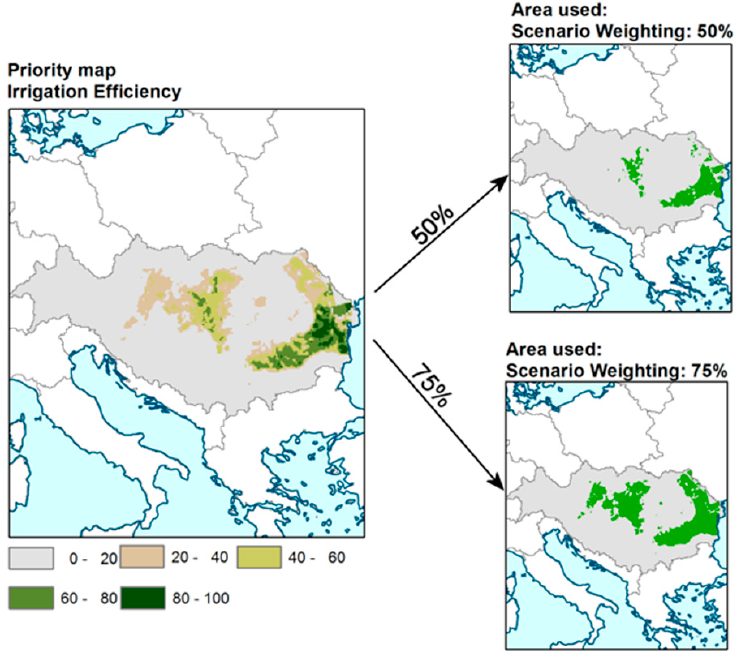
Figure 3. Scenario intensity example: Priority map for the Irrigation Efficiency measure in the Danube Region.